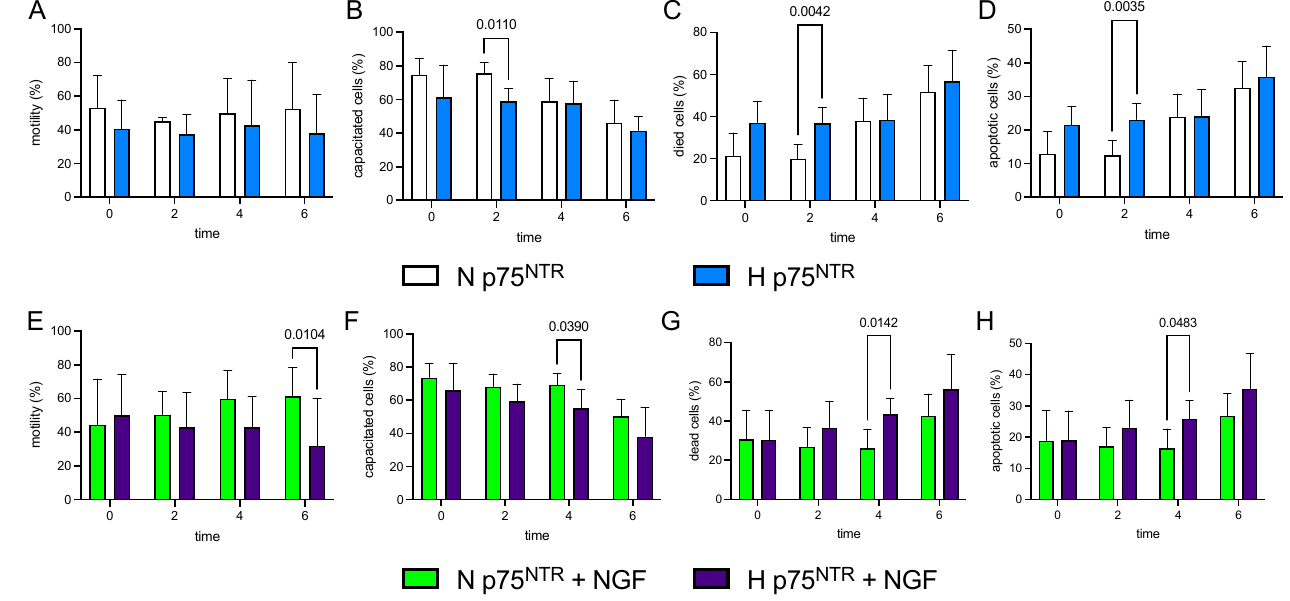
Figure 2. Effect of NGF treatments (100 ng/mL) on Normal and High p75 NTR cells during storage times (0, 2, 4, 6 h). Bar charts display Normal and High p75 NTR -untreated (white, N and blue, H) and NGF-treated (green, N + NGF, and purple, H + NGF) for distinct time-points (0, 2, 4, 6 h) and different sperm parameters: ( A , E ) Motility rate (%); ( B , F ) Capacitated cells (CP, %); ( C , G ) Dead cells (%); ( D , H ) Apoptotic cells (%).